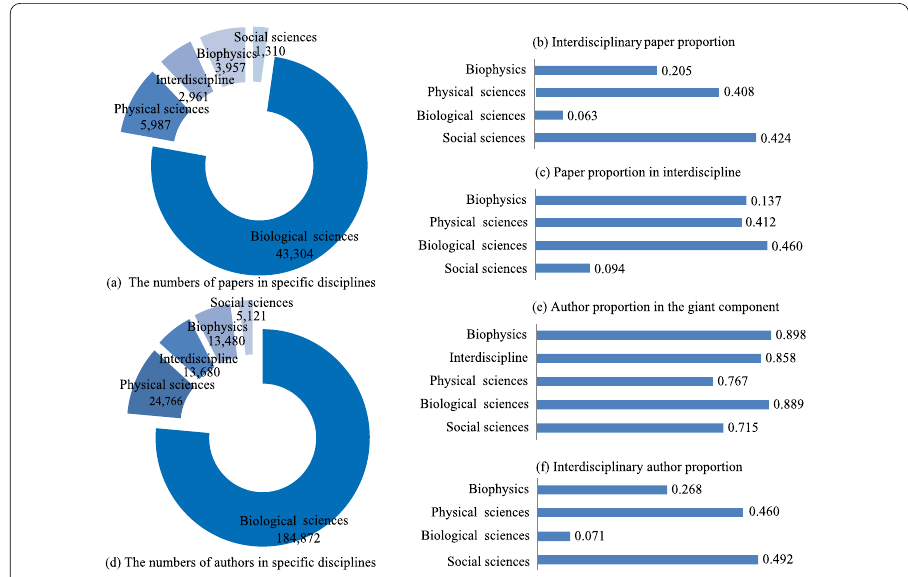
Figure 7 Interdisciplinary extents of specific disciplines. For each considered discipline i , we denote its authors, its authors involved in interdisciplinary research, its papers, and its interdisciplinary papers by sets A i , A I , P i and P I respectively. Denote the giant component of coauthorship network PNAS 1999–2013 by S . The i i indexes are | P